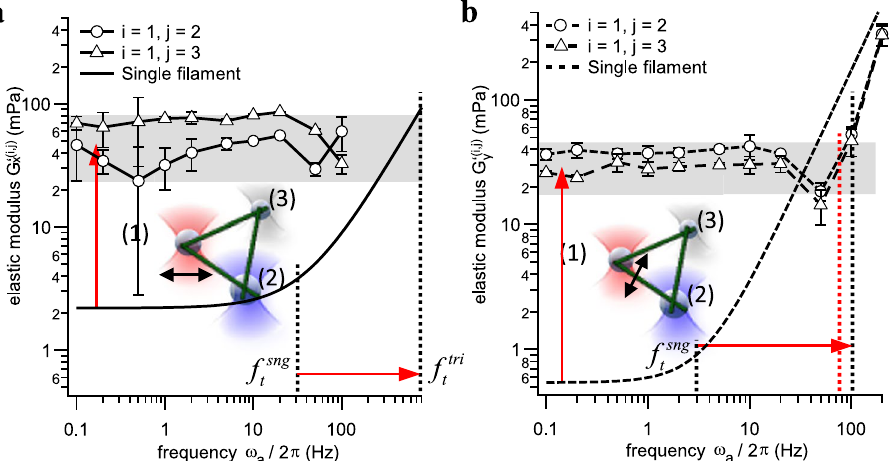
Figure 6. Elastic components G ′ ( ω ) for an equilateral triangular network. These are compared to the theoretical estimates for single filaments (lines without markers). ( a ) Radial oscillation along x . ( b ) Tangential oscillation along y . Error bars represent the standard deviation (SD) of N = 10 measurements